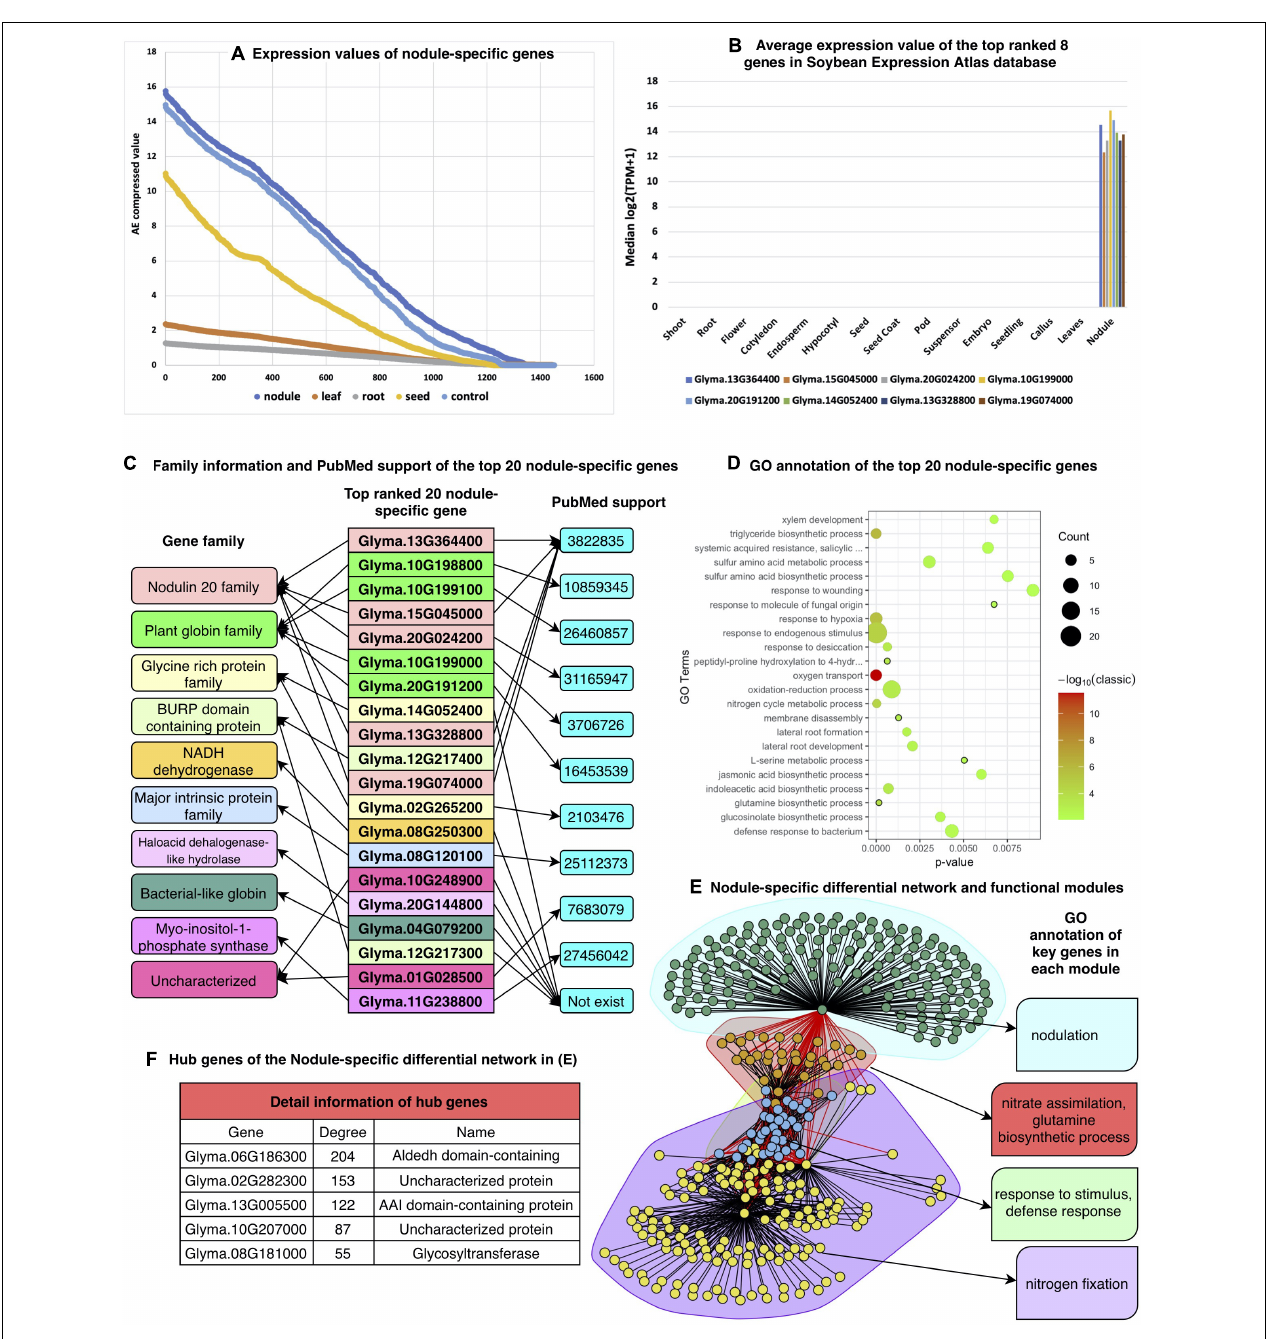
FIGURE 6 | Results of nodule-specific gene analysis. (A) Expression values of 1,451 nodule-specific genes compared with those in other tissues, (B) validation of the expression patterns of top-ranked nodule-specific genes from the Soybean Expression Atlas database, (C) detailed gene family and PubMed support for the top-20 ranked nodule genes. Genes with the same color are in the same gene family. (D) GO biological process annotation of the top 20 nodule-specific genes, (E) differential correlation network of the nodule-specific genes and key function of each module, and (F) hub genes of each